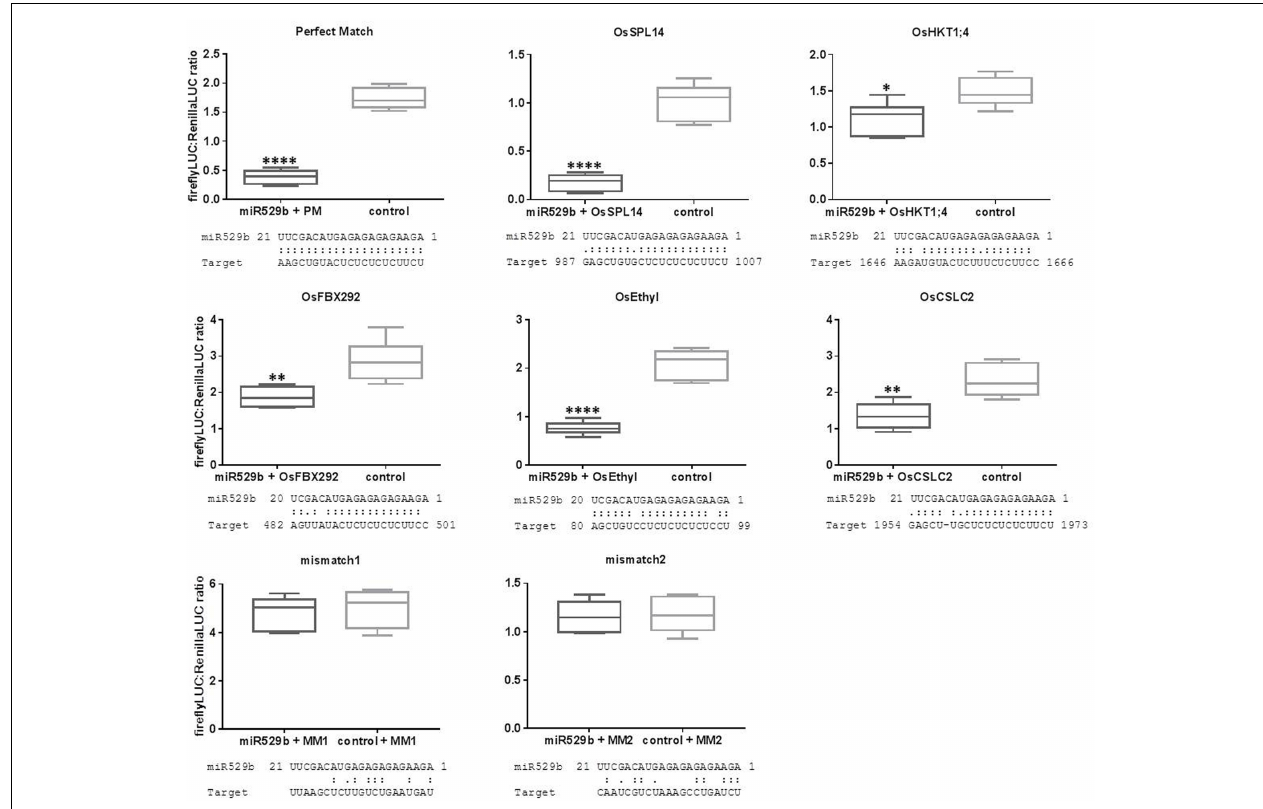
FIGURE 8 | Experimental validation of rice transcript sequences computationally predicted to be targeted by rice miR529b. Each control consists of assays where the miR529b precursor culture was replaced with a precursor construct culture that does not target the rice sequences. Mismatch1 (MM1) and mismatch2 (MM2) negative control assays use target sequences with little complementarity to the miR529b miRNA. The results are depicted as box and whisker plots, with interquartile range boxes and min/max whiskers ( n = 6). Asterisk represents statistically significant differences using a simple two-tailed unpaired t -test with ∗ P < 0.05, ∗∗ P < 0.005, and ∗∗∗∗ P <